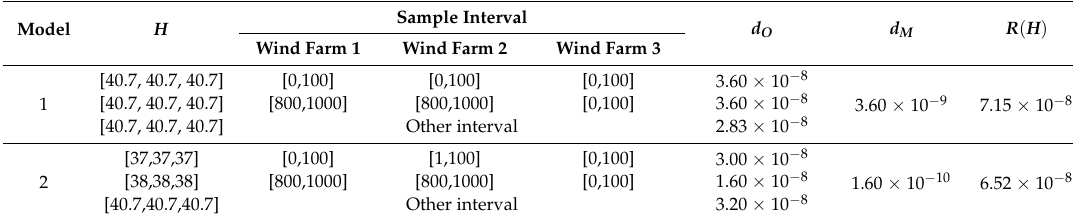
Table 2. Comparison of AMNKDE and MNKDE.